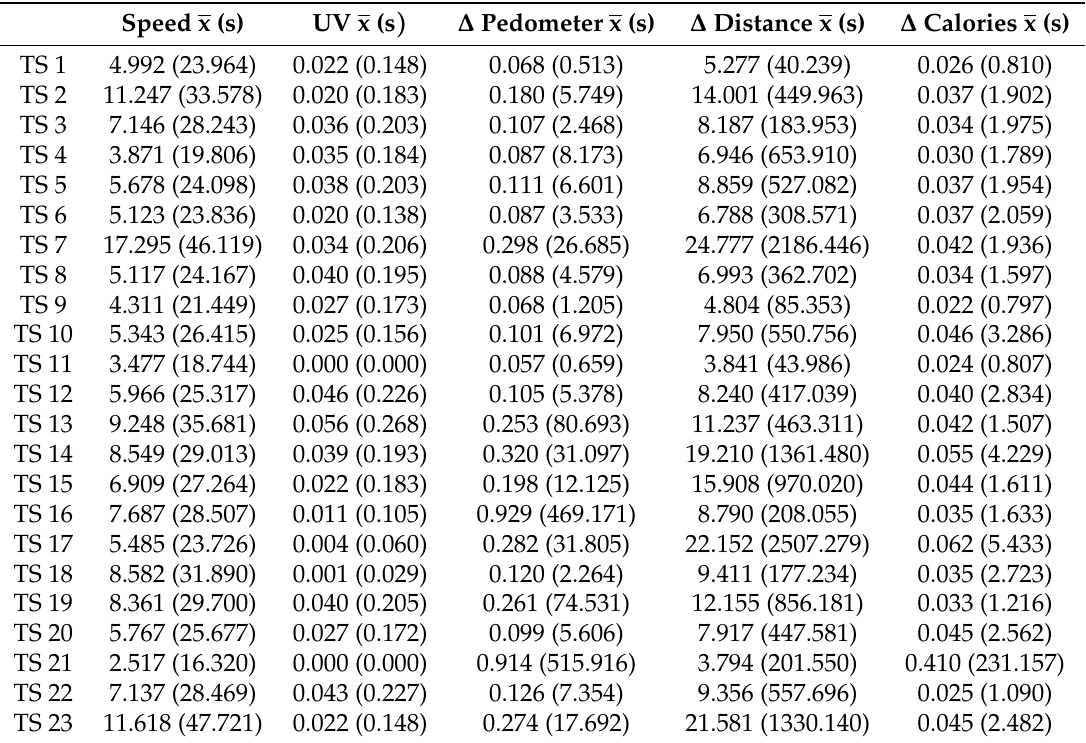
Table A3. Normal conditions dataset. Part III.